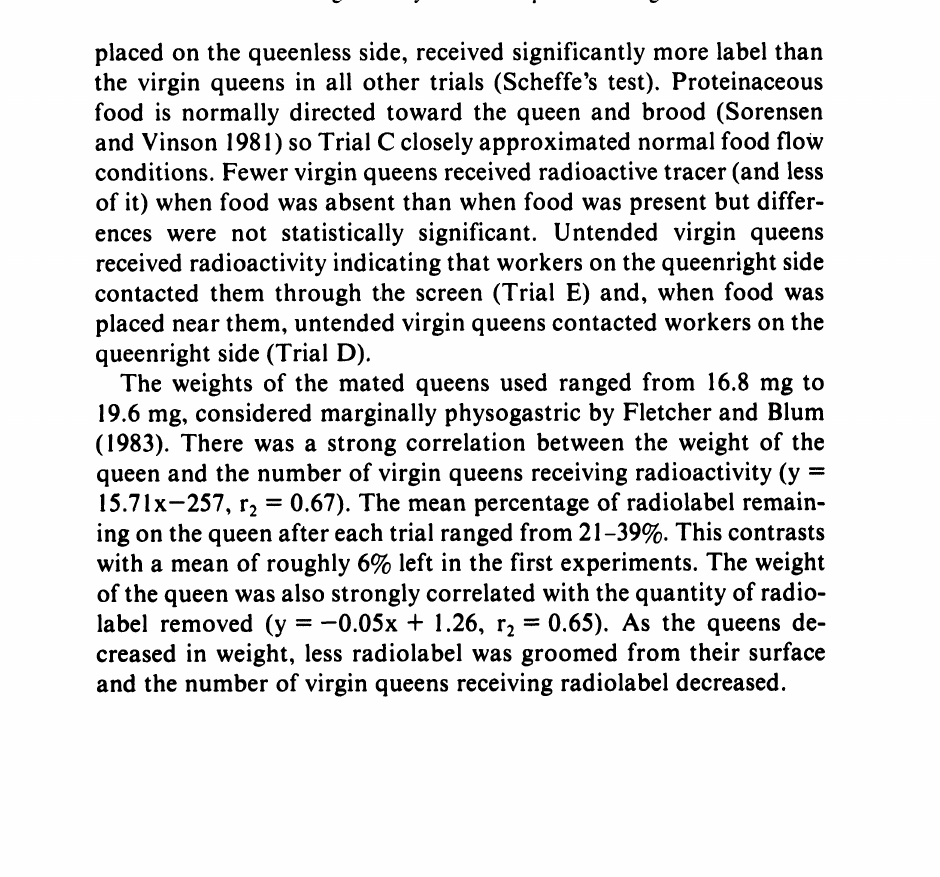
Figure 4. Number of virgin queens containing radioactivity following reintroduc- tion ot’the mated queen who was surface labeled with radiolabel (*). Five trials (A-E) were conducted on each of 6 colonies with no food, food on the queenright or queenless side, and virgin queens with or without workers. Boxes were divided with screens which allowed trophallaxis and limited antennai contact. Radioactivity (counts per minute or cpm) was measured after h. Results are given as means and standard deviations for all virgin queens measured (within boxes) and for only those virgin queens that received radioactivity (below boxes). Means followed by the same letter in each row are not significantly different at p < 0.05 using Scheffe’s